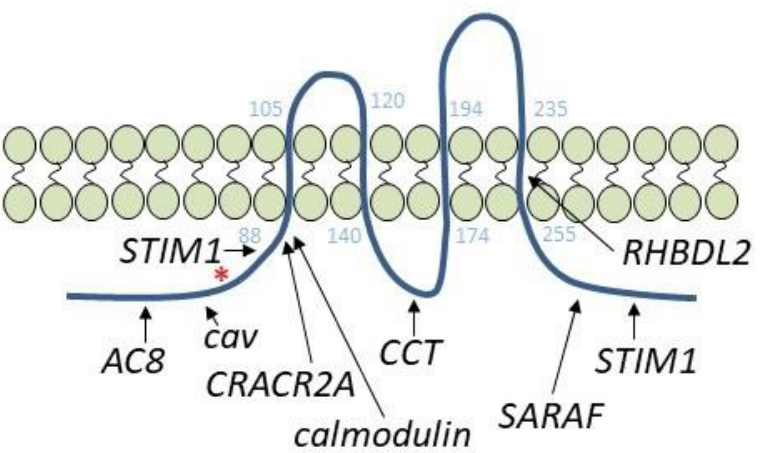
Figure 2. Cartoon depicting the most relevant Orai1-interacting proteins: AC8, adenylyl cyclase isoform 8; cav, caveolin-1; CRACR2A, CRAC regulator 2A; CCT, chaperonin-containing TCP-1; SARAF, SOCE-associated regulatory factor; RHBDL2, rhomboid-like 2. The residues that delimit the transmembrane domains are represented in light blue. The asterisk indicates the start of Orai1β.